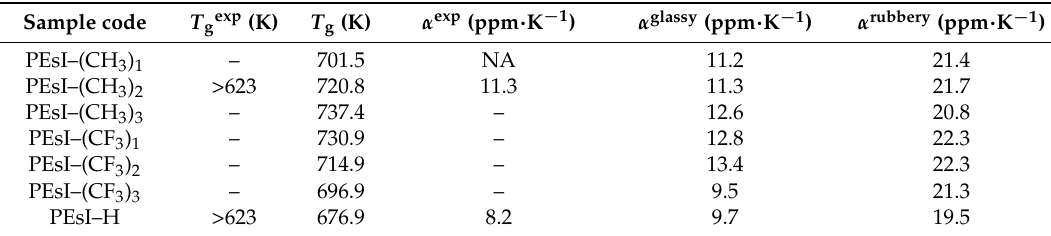
Table 1. Glass-transition temperature ( T g ) and thermal expansion coefficients ( α ) of the seven poly(ester imide) (PEsI)